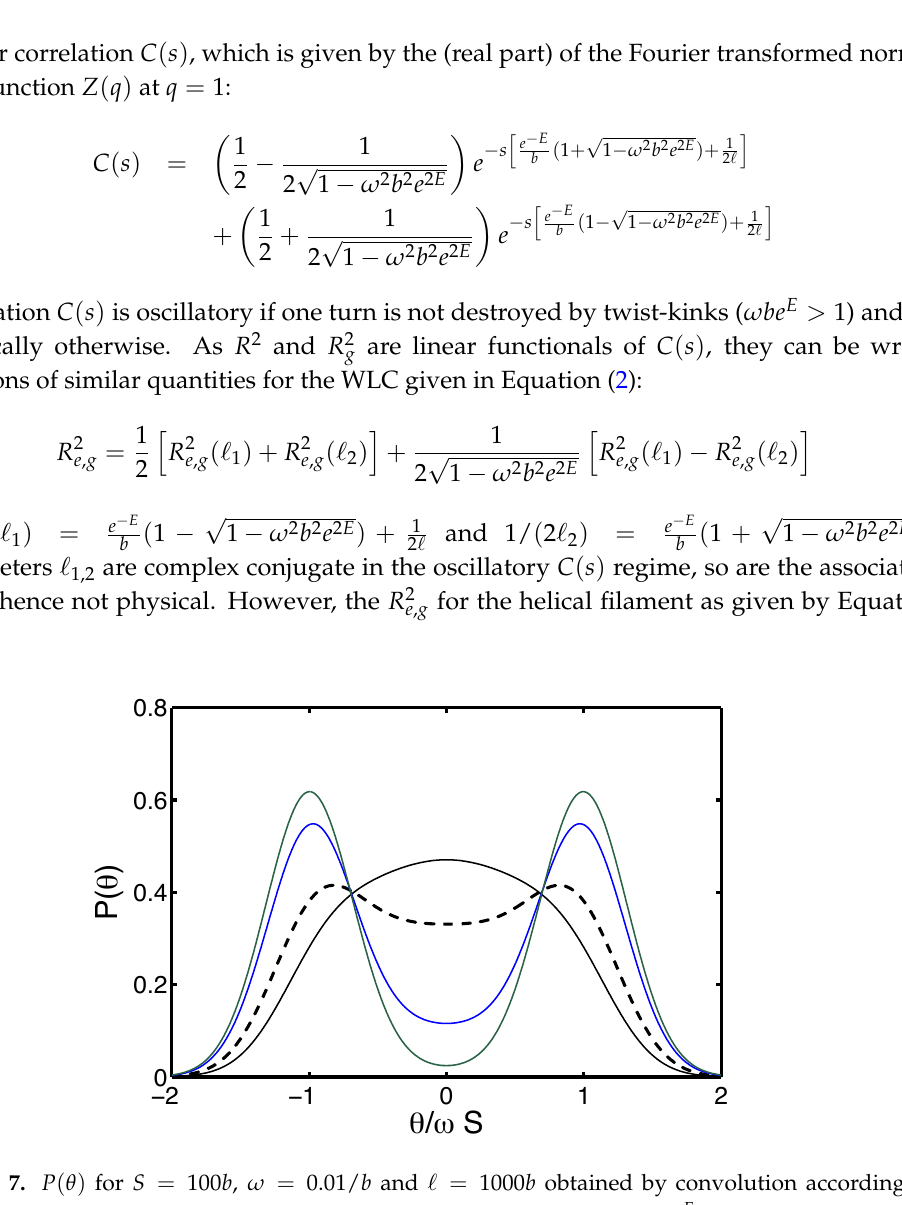
Figure 7. P ( θ ) for S = 100 b , ω = 0.01/ b and (cid:96) = 1000 b obtained by convolution according to Equation (23) using Equation (22). The Boltzmann weight of a twist kink is e − E . The lines correspond to E = 4 (green), 6 (blue) and 8 (black). The thick dashed line corresponds to E = − log ( b ω ) ≈